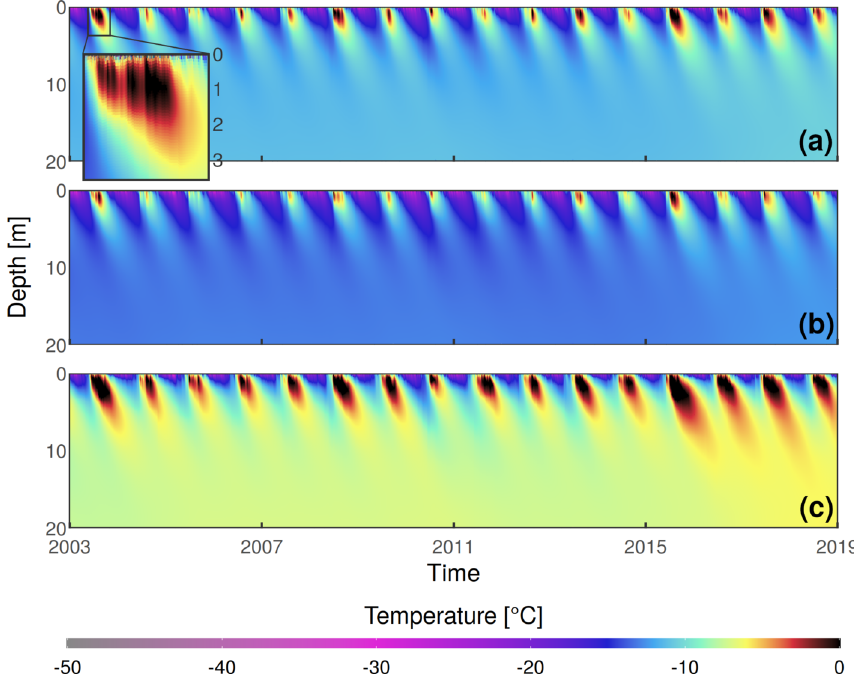
Figure 6. Time–depth plots of modeled firn temperatures at (a) SP, (b) SK, and (c) ZS (map in Fig. 1a). A 100m grid and 3h time step are shown. Inset shows 2003 summer temperatures down to 3.5m depth. The annual cycle becomes smaller than 0.1 ◦ C at approximately 15m depth and further decreases beyond the model quantization noise (due to the vertical layer discretization) by 20m.